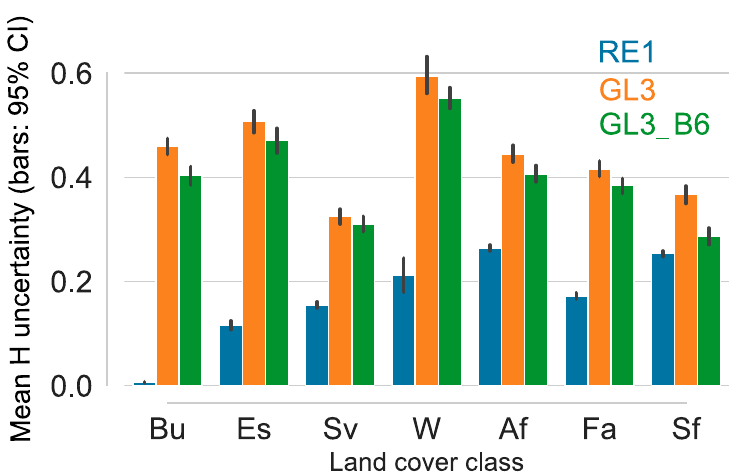
Figure 10. A comparison of the validation by Shannon Entropy ( H ) estimation. The class uncertainty estimates are significantly improved by GL3_B6, as can be observed for Built-up areas (Bu), Cocoa agroforests (Af), Subsistence farmlands (Fa), and Transition forests (Fs).